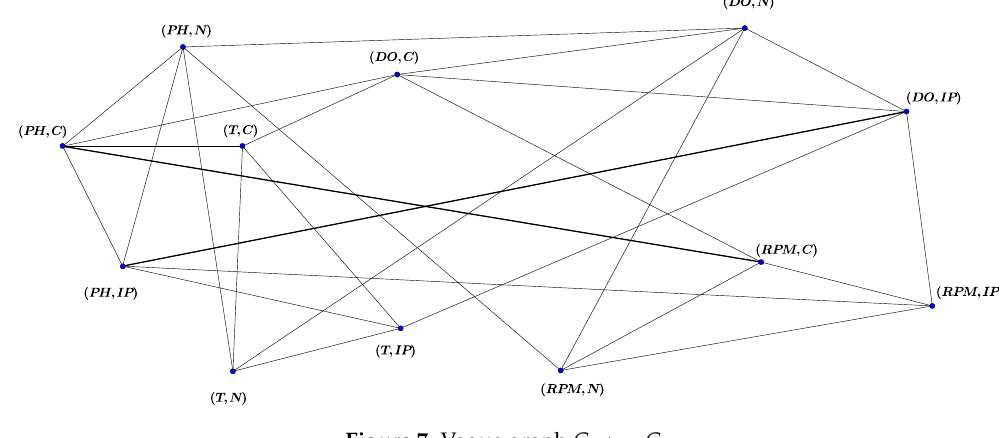
Figure 7. Vague graph G 1 ∗ M G 2